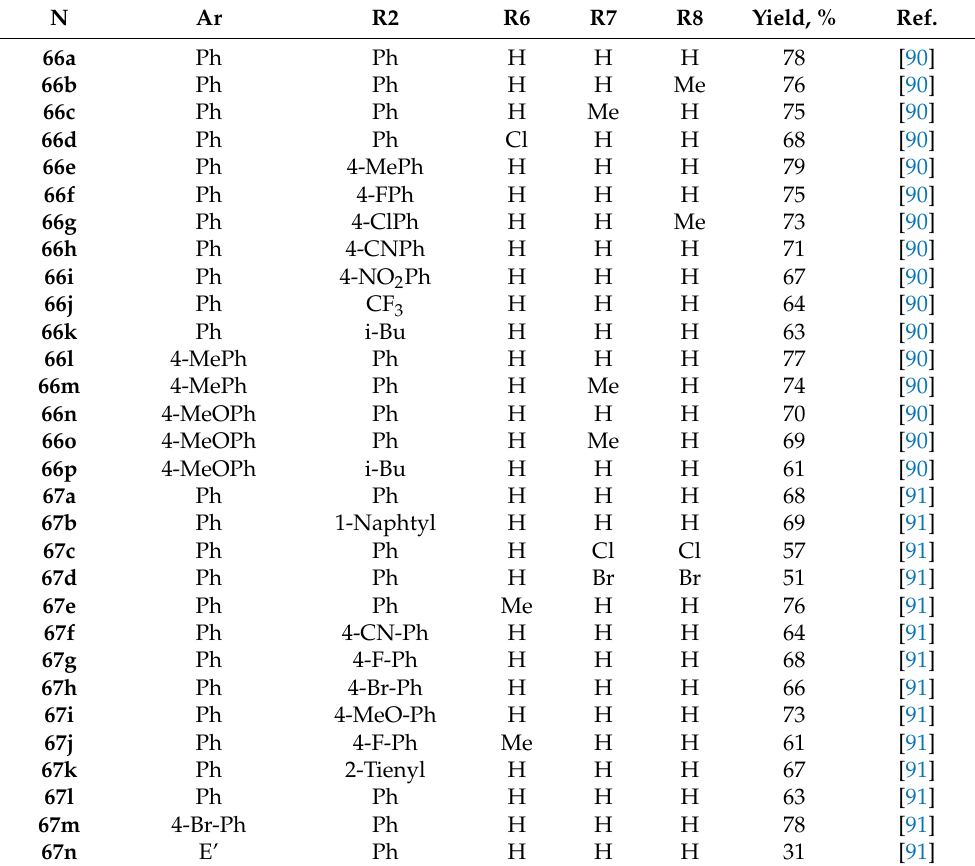
Table 15. Substituents and yields of reaction of 2-arylimidazopiridines and diarylacetylenes (Scheme 33).